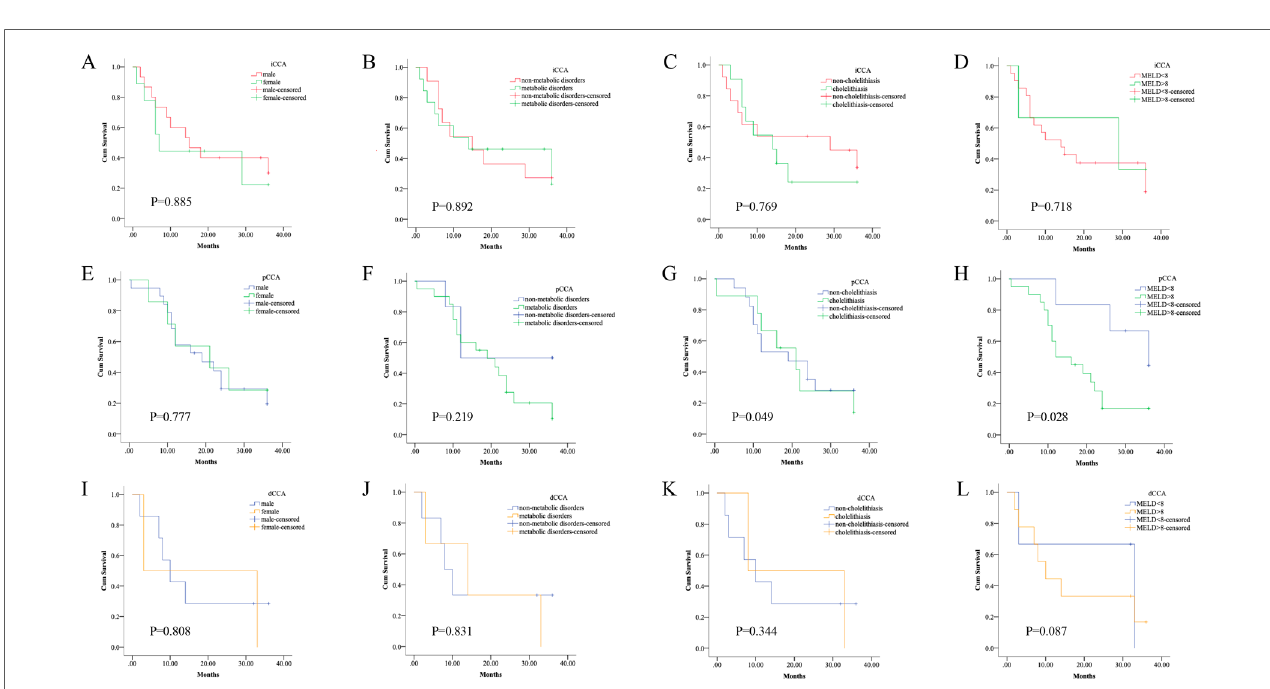
FIGURE 2 Survival of the subtypes of CCA patients. Kaplan – Meier curves show no differences in the postoperative median follow-up time between iCCA, pCCA and dCCA patients, log-rank p >0.05.